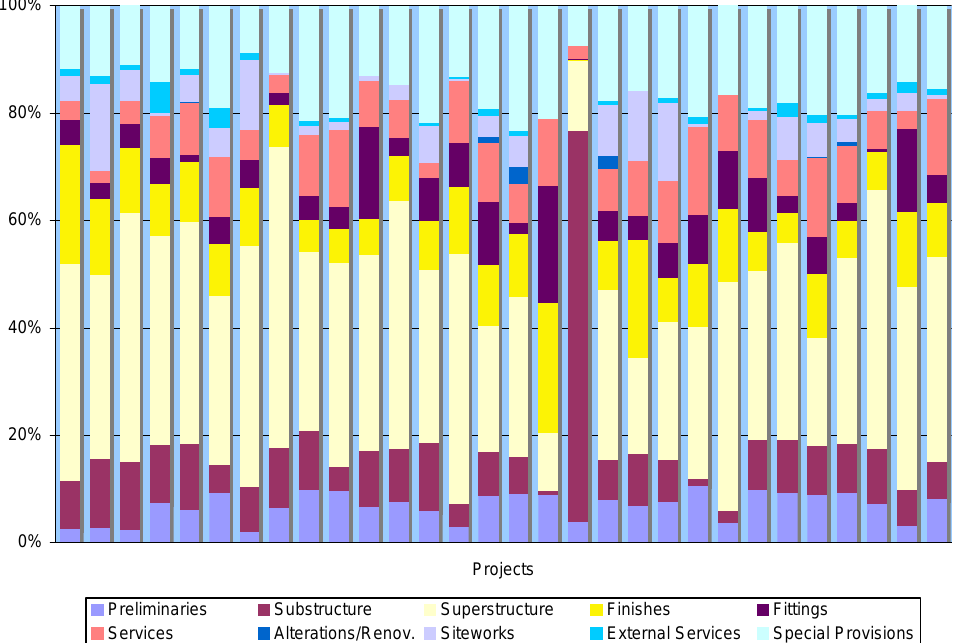
Figure 3 : Distribution of Initial Embodied Energy